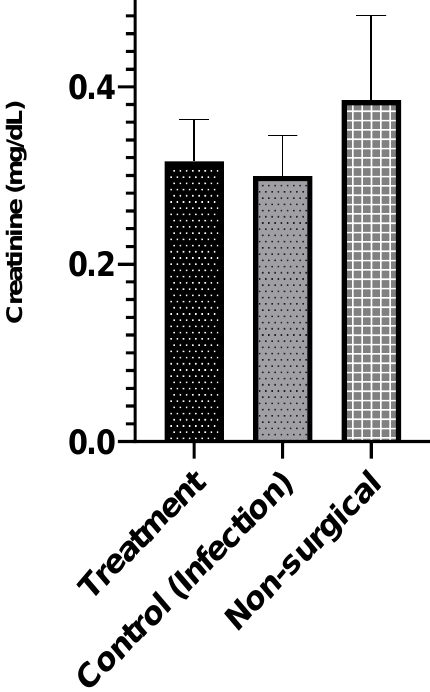
Figure 5. Serum creatinine level shows no significant di ff erence between the infection treatment ( n = 4), infection control ( n = 6), and non-surgical (no infection) control groups ( n = 3). The serum creatinine level seems to be within normal limits (α = 0.05).